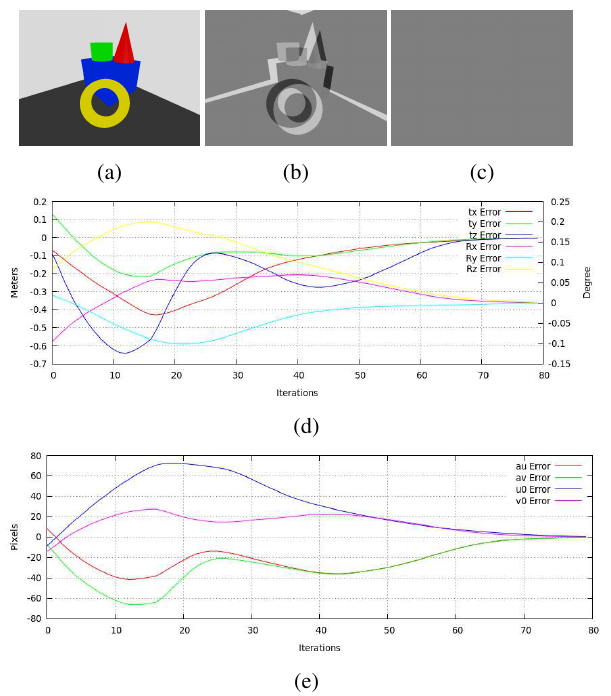
Figure 5: Simulated experiment : (a) desired image, (b) differ- ences between desired and inital image, (c) differences between desired and final image, (d) translations and rotations error, (e) intrinsic camera parameters